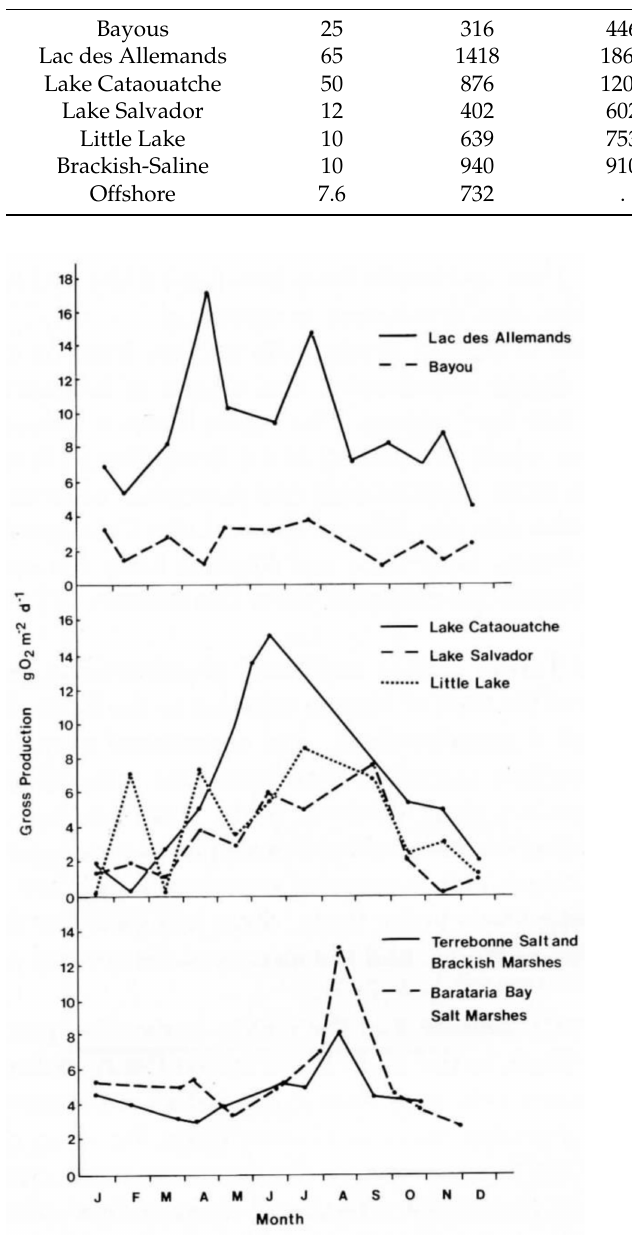
Figure 11. Gross production of major lakes and bayous in Barataria Bay going from fresh ( upper ), low salinity ( middle ), to salt water conditions ( lower ; from [44]; data collected